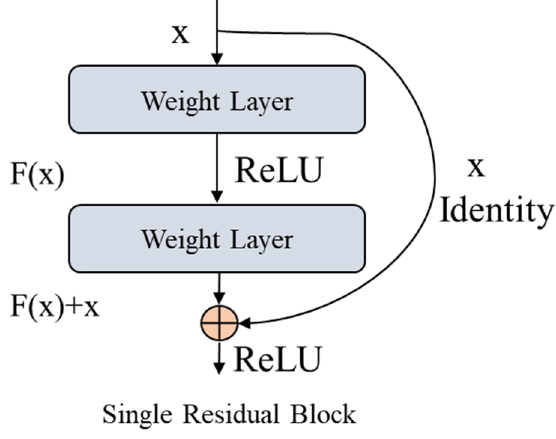
Figure 6. Representation of skip connection or residual concept in GRU.